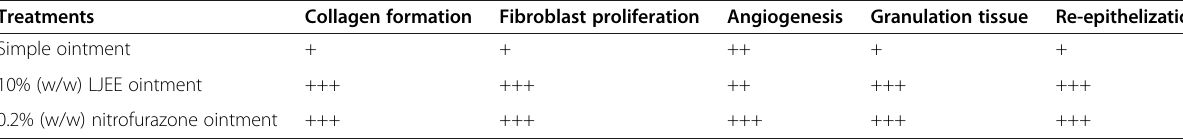
Table 3 The histopathological scores on healed wounds from LJEE and nitrofurazone ointment-treated animals